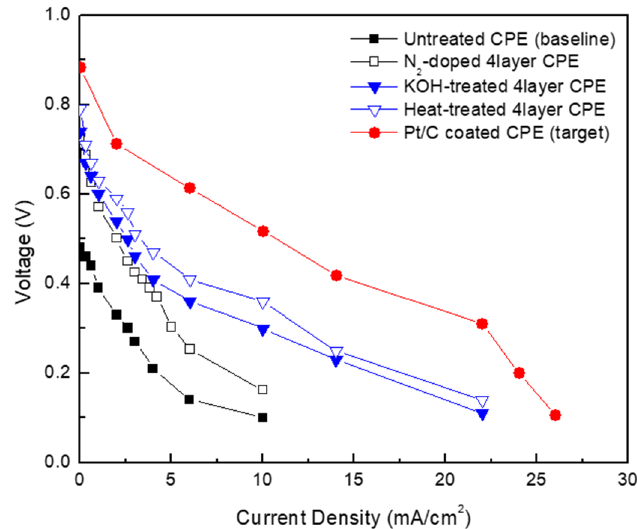
Figure 7. Performance comparison for cells consisting of an untreated carbon porous electrode (CPE), N 2 -doped CPE, KOH-treated CPE, thermal-treated CPE, and Pt supported on carbon (Pt/C)-coated CPE as a cathode electrode. Especially, four layers of treated carbon papers were stacked to make multi-layered electrodes for the cases of N 2 -doped CPE, KOH-treated CPE, and thermal-treated CPE.